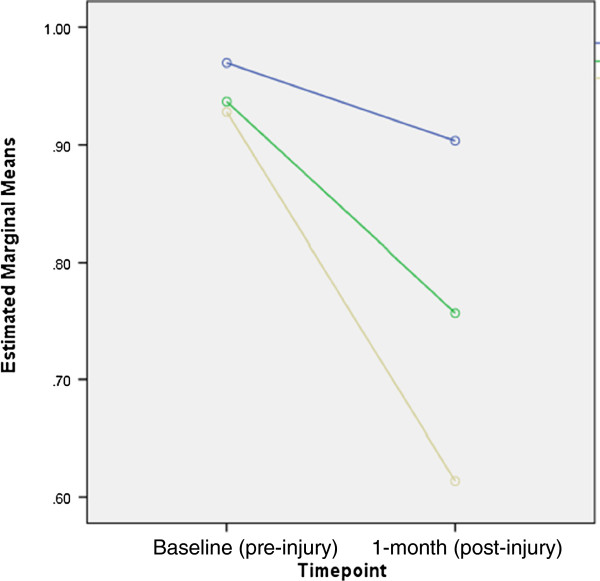
Estimated marginal means of EQ-5D-3 L descriptive scale scores at baseline and 1 month post injury. Figure legend, Length of stay: “Blue circle symbol”: not admitted; “Green circle symbol”: 1–3 days in hospital; “Dark yellow circle symbol”: 4 or more days in hospital.